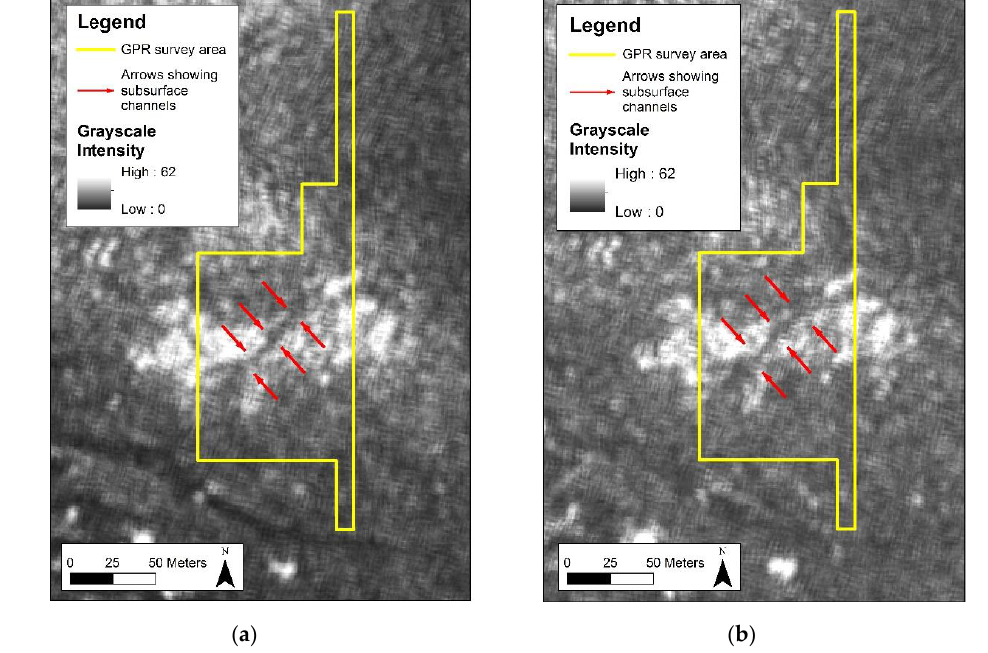
Figure 4. TanDEM-X bistatic image coregistered stacks (grayscale intensity images processed with Gray Level Co-occurrence Matrix ((GLCM)) variance texture analysis), with black representing low intensity values and white representing high intensity values. ( a ) Summed stack of 10 VV images. ( b ) Summed stack of 6 HH images.